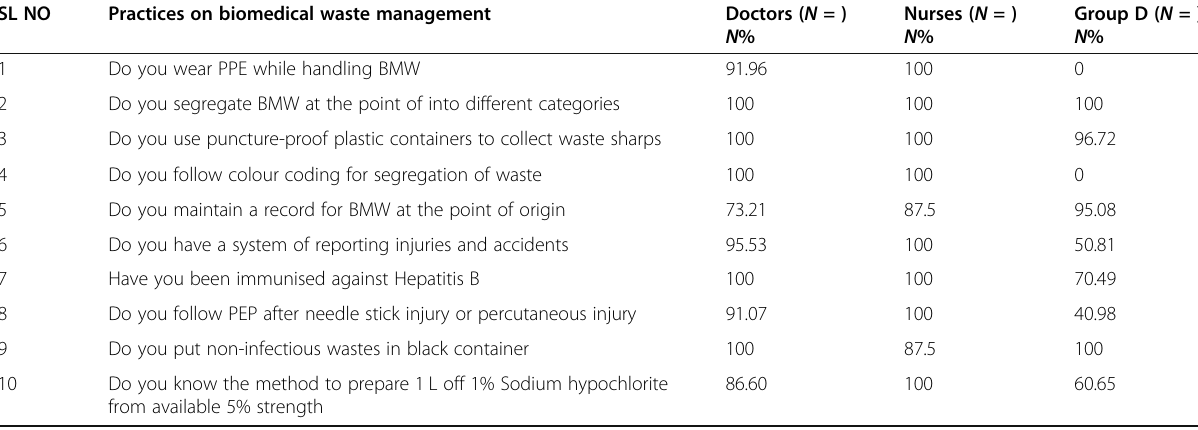
Table 3 Practices of health care workers on BMW management SL